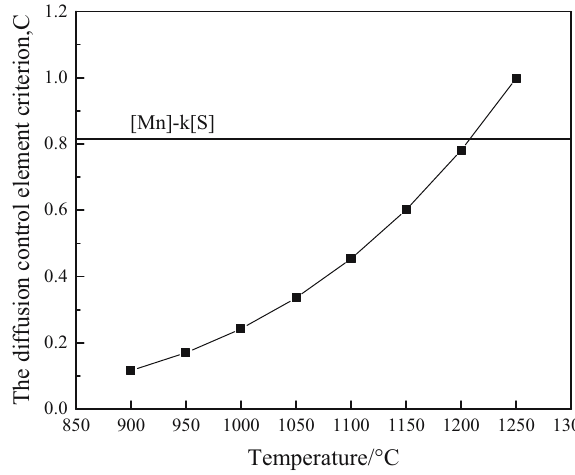
Figure 10: The relationship between [ Mn ]- k [ S ] and the diffusion control element criterion.